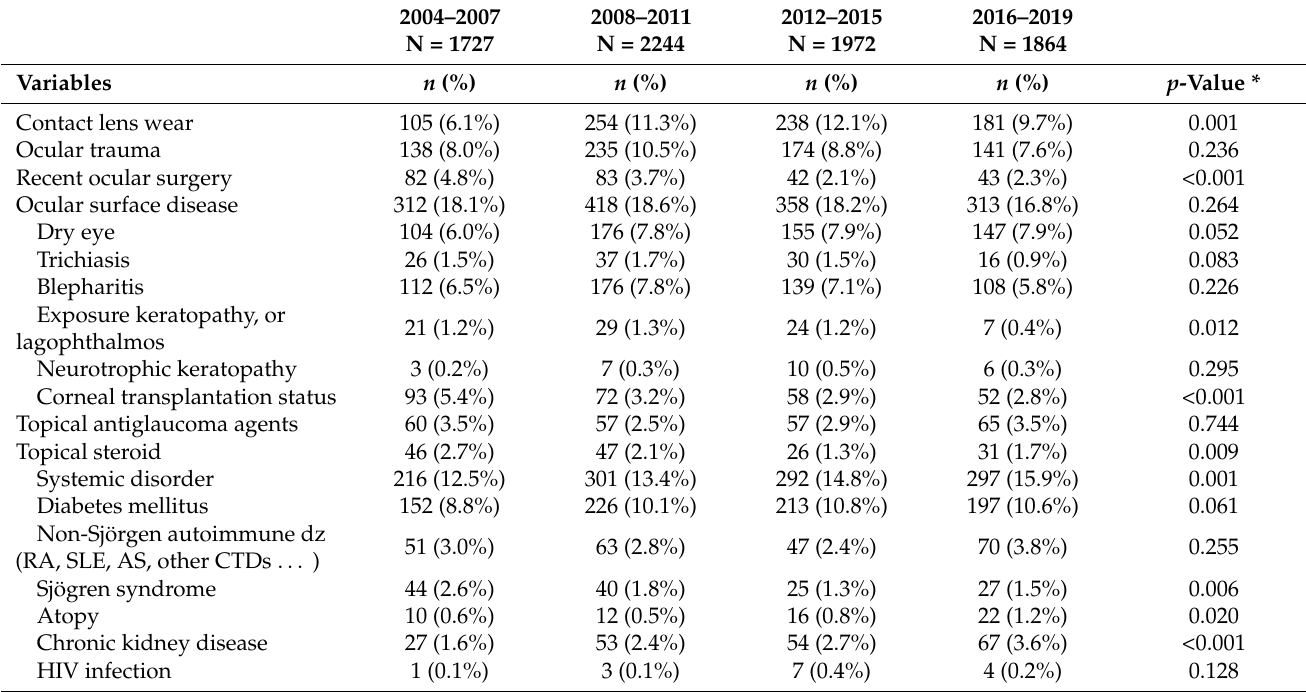
Table 2. Distribution of identifiable predisposing factors for infectious